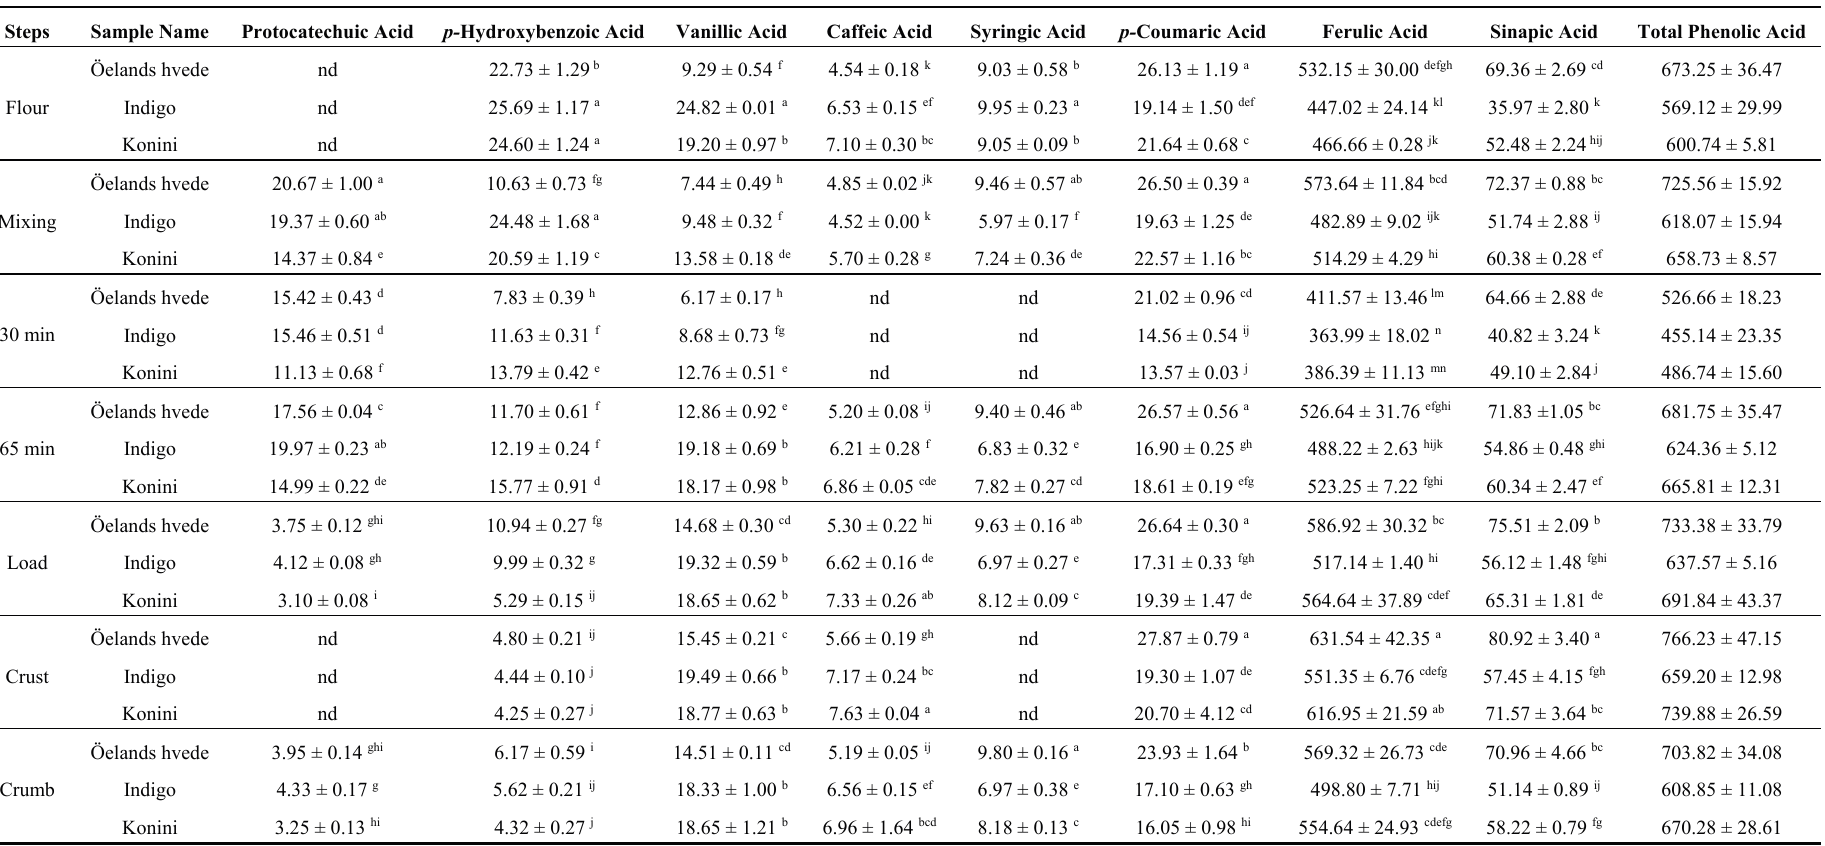
Table 3. Composition of insoluble-bound phenolic acids in normal and purple wheat grains at different stages of the bread-making